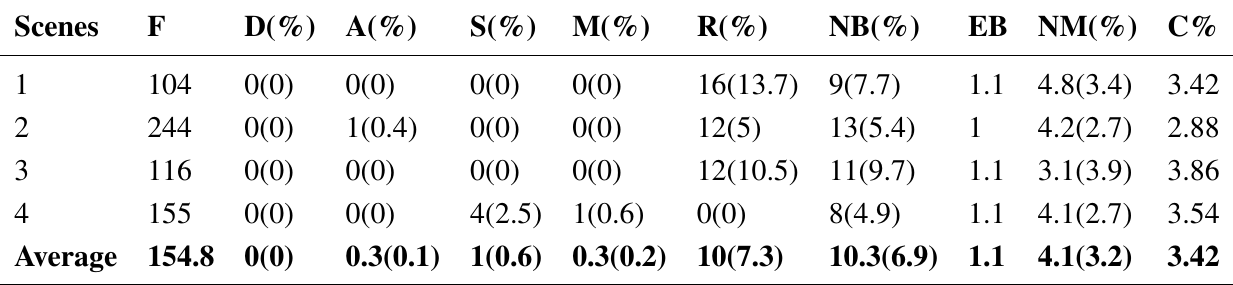
Table 8. Estimation of manual interactions to update the building map using the GUI from the existing map and automatically-extracted building footprints in 2012. F = number of automatically-extracted footprints, D = number of deletions for removing false buildings (trees), A = number of additions for the inclusion of missing true buildings, S = number of split operations, M = number of merge operations, R = number of replacement operations, NB = number of detected buildings being edited to be acceptable, EB = number of editions per edited building, NM = number of mouse clicks per edition and C% = percentage of clicks to total